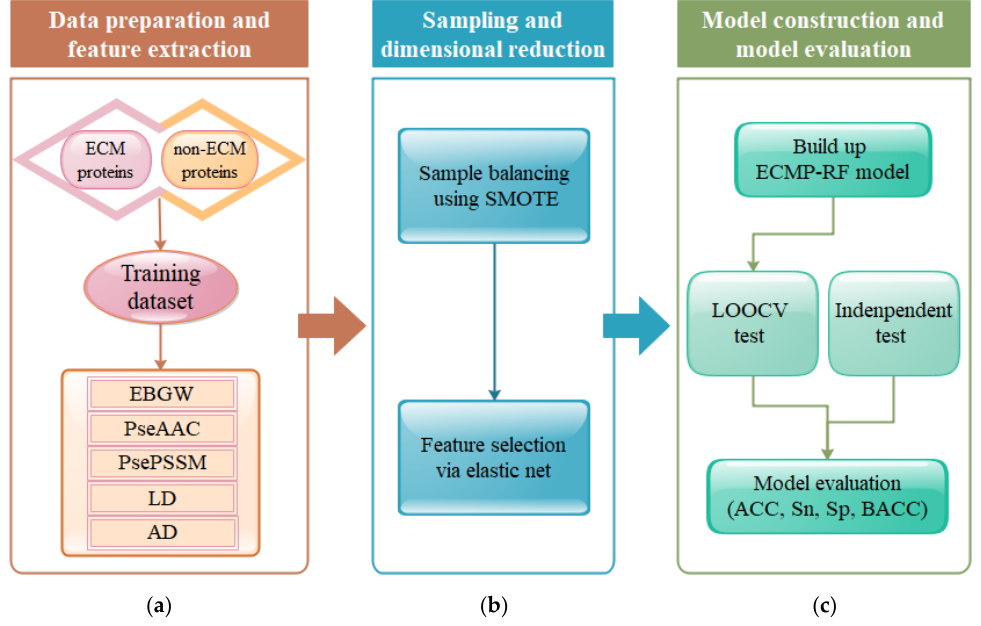
Figure 1. The flowchart of the ECMP-RF method: ( a ) data preparation and feature extraction; ( b ) sampling and dimensional reduction; ( c ) model construction and model evaluation.